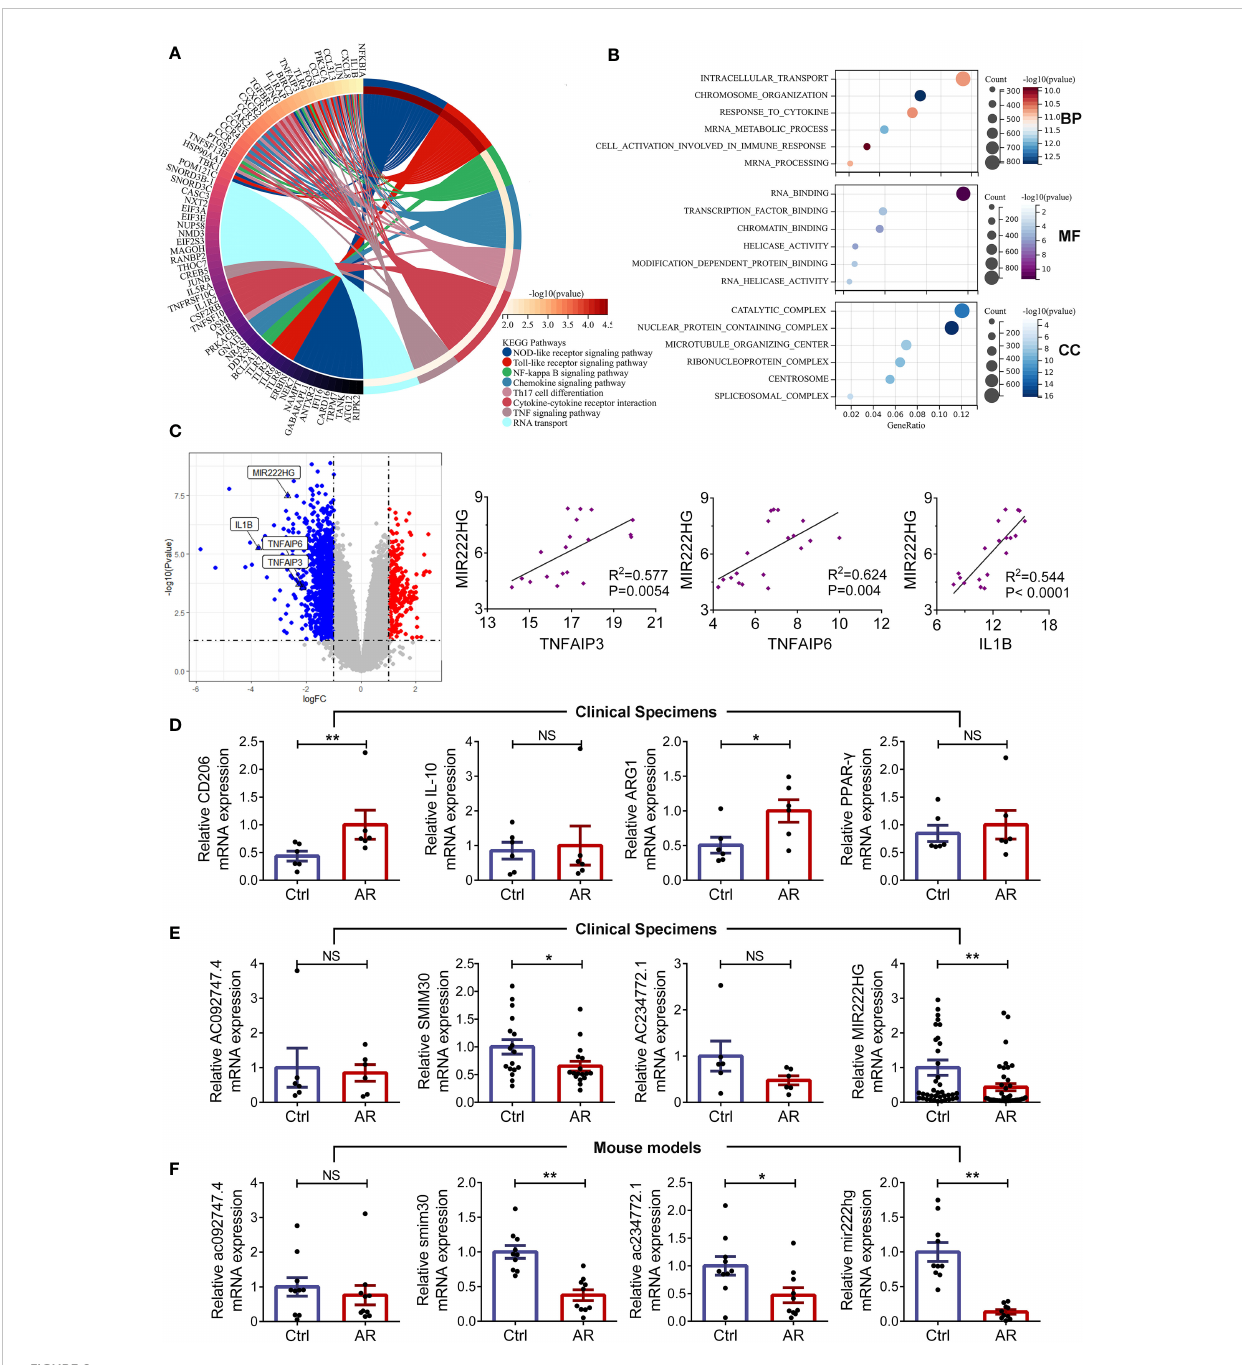
FIGURE 2 MIR222HG is signi fi cantly downregulated in allergic rhinitis (A) Circos plot displaying the Kyoto Encyclopedia of Genes and Genomes (KEGG) analyses of DE-mRNAs. (B) Bubble chart of Gene Ontology (GO) enrichment analyses of DE-mRNAs, including the biological process (BP), molecular function (MF) and cellular component (CC) categories. (C) Volcano plots highlighting the fold changes and signi fi cant differences in the expression of TNFAIP3, TNFAIP6, IL1B, and MIR222HG. Correlation analysis of the expression levels of TNFAIP3, TNFAIP6 or IL1B, and MIR222HG in the microarray data (Spearman rank correlation). (D) The relative mRNA level expression levels of CD206, IL-10, ARG1, and PPAR- g were detected in AR patients and healthy controls by qRT-qPCR. (E) The relative transcript-level expression levels of AC092747.4, SMIM30, AC234772.1, and MIR222HG were validated in AR patients and healthy controls by qRT-qPCR. (F) The relative transcript-level expression levels of ac092747.4, smim30, ac234772.1, and mir222hg were validated in the animal model of AR. Each point represents data from one individual sample. Data are shown as the mean ± SEMs (n= at least 6 samples per group). Data are merged from three independent experiments. Statistical signi fi cance was calculated by unpaired t-test. * p< 0.05, ** p< 0.01, NS no signi fi